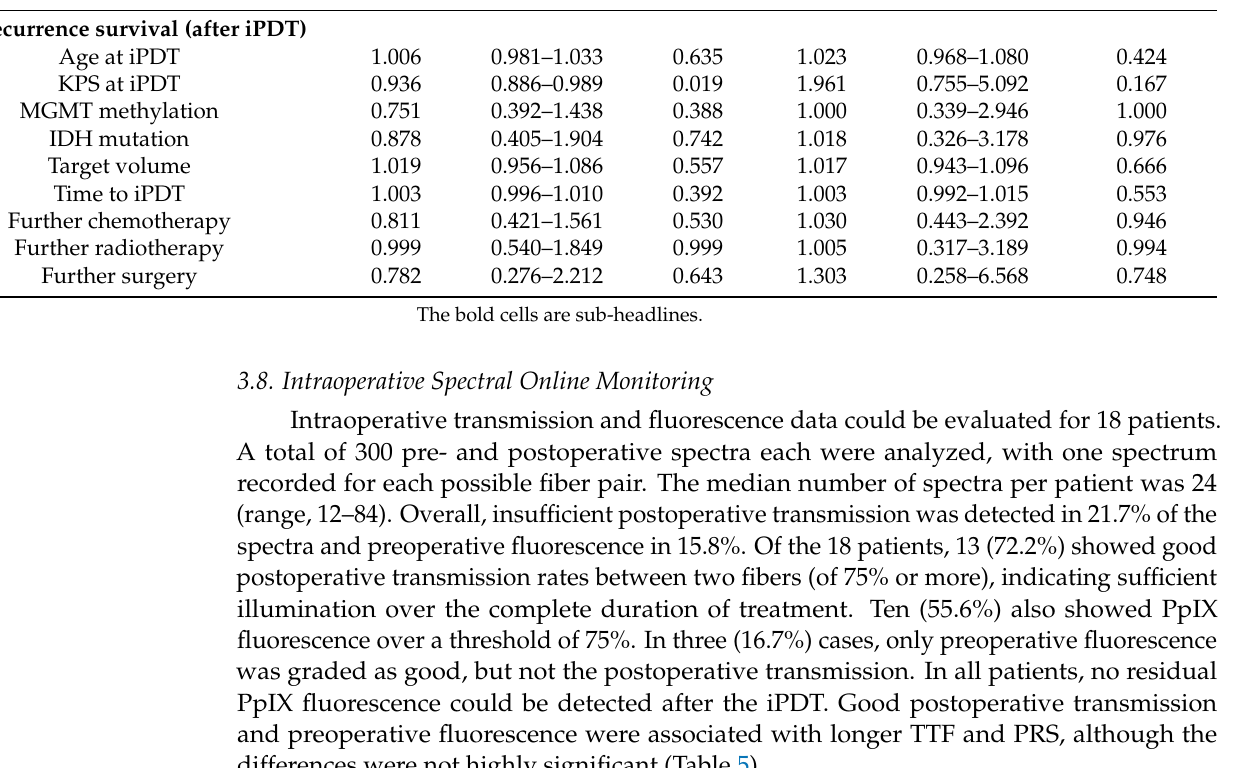
Table 4. Prognostic factors for PRS after iPDT in uni- and multivariate models; HR—hazard ratio, CI—confidence interval. Characteristic